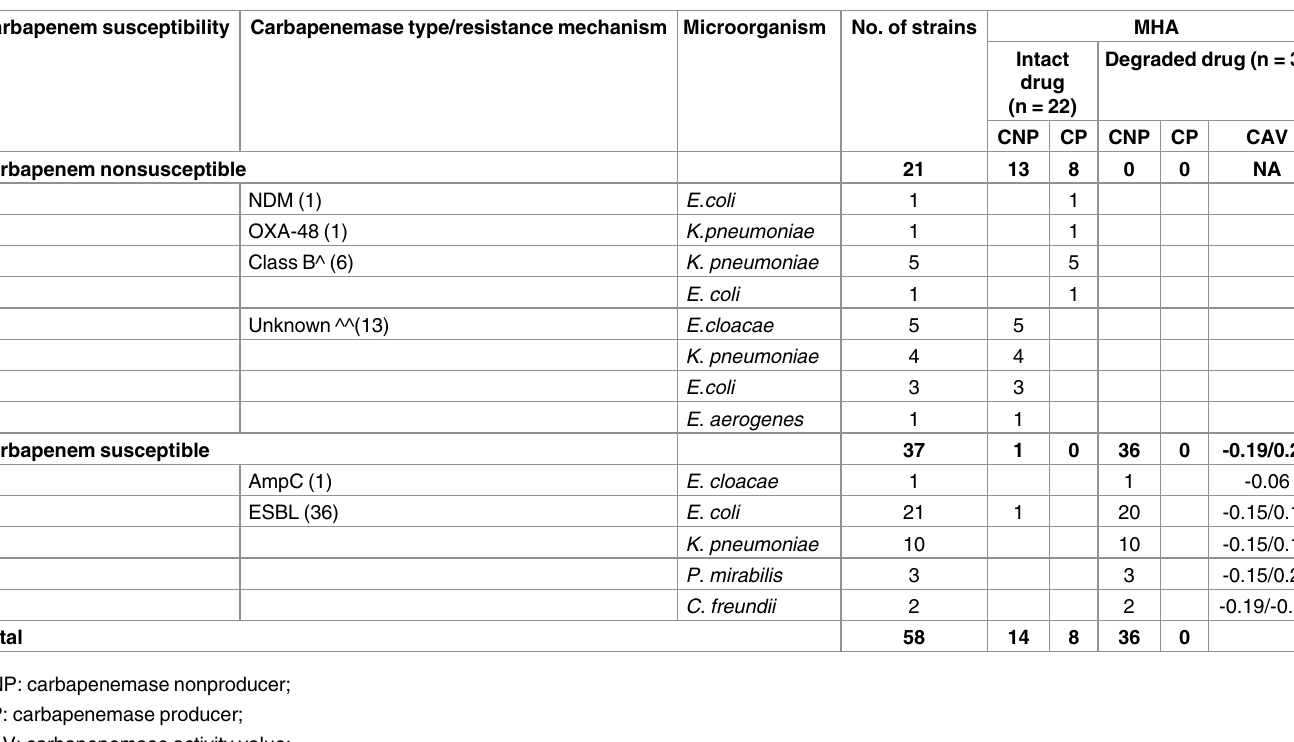
Table 3. Results of Meropenem Hydrolysis Assay(MHA) in case of intact or degraded drug in 58 Enterobacteriaceae strains included in the panel III.